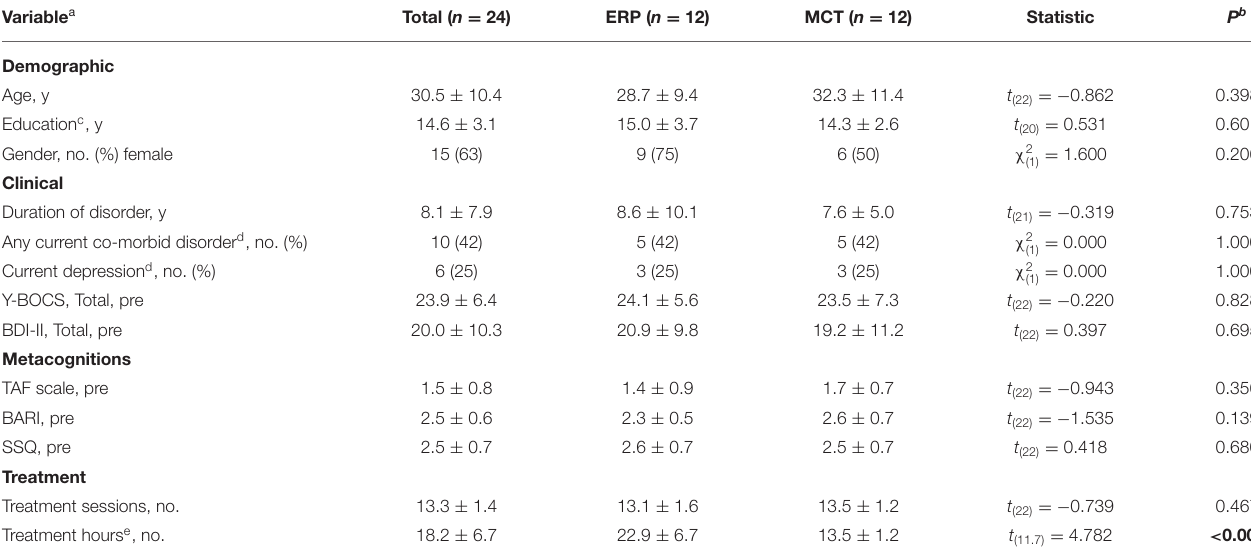
TABLE 1 | Demographic and clinical characteristics of participants. Variable